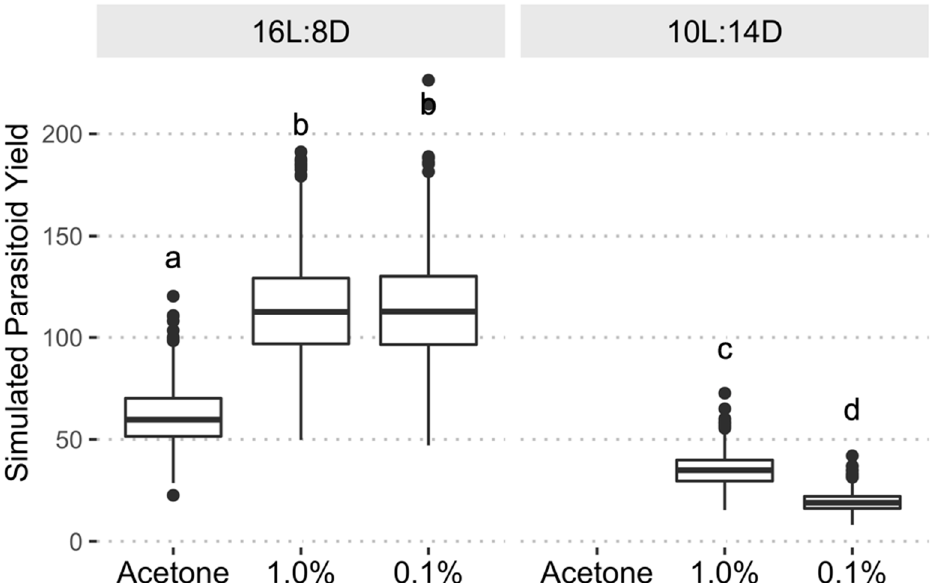
Figure 6. Estimated parasitoid yield from bootstrap simulations ( n = 2000) using model estimates of egg production and parasitoid viability. The long-day photoperiod significantly increased parasitoid yield over short-day treatments, while within the long-day photoperiod the pyriproxyfen treatments produced similar parasitoid yields and yielded significantly more parasitoids than the acetone treatment. Boxplots with the same letter are not significantly different ( α = 0.05, estimated mar- ginal means with Tukey’s method of adjustment for multiple comparisons).